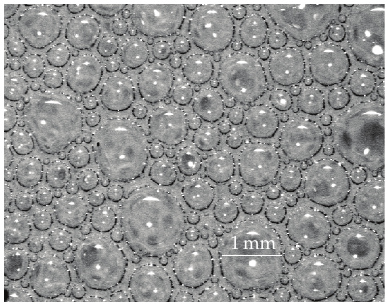
Figure 1: A foam image at 190